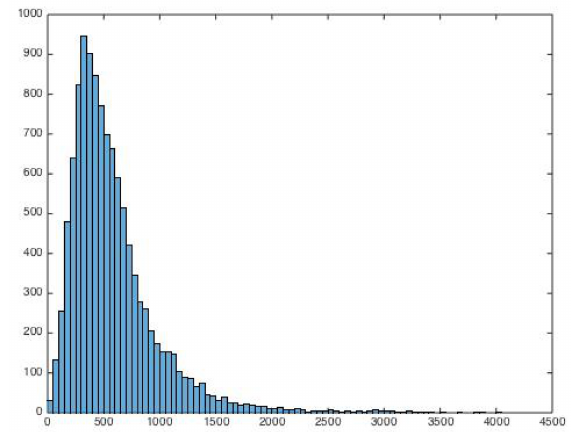
Figure 4. Landsat image of a section of the Larsen C Ice Shelf where melt lakes were present on 6 January 2016. Both axes have units of metres. Here the lakes are coloured yellow and areas where lakes were not present are coloured blue. Although these data were taken from the Landsat 8 mission at a later time than the simulation using the 2010–2011 melt season, it is likely that the lakes will be similar in many aspects due to the role of topography in the loca- tion of lake basins. Landsat 8 image courtesy of the U.S. Geological Survey.